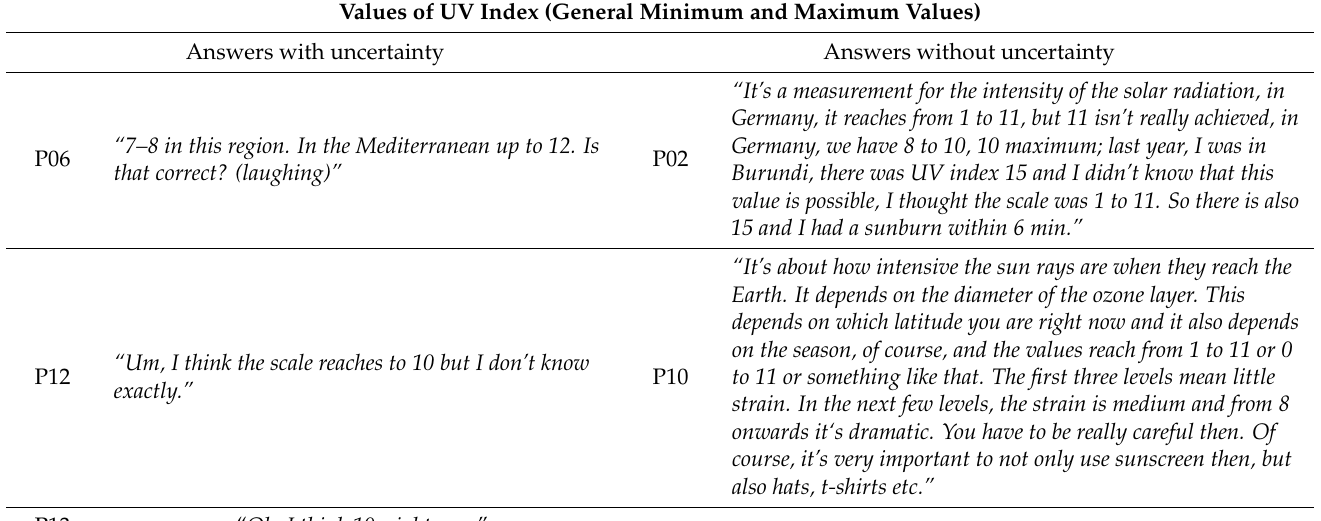
Table 3. Answers regarding the values of UV index by pharmacists and pharmaceutical